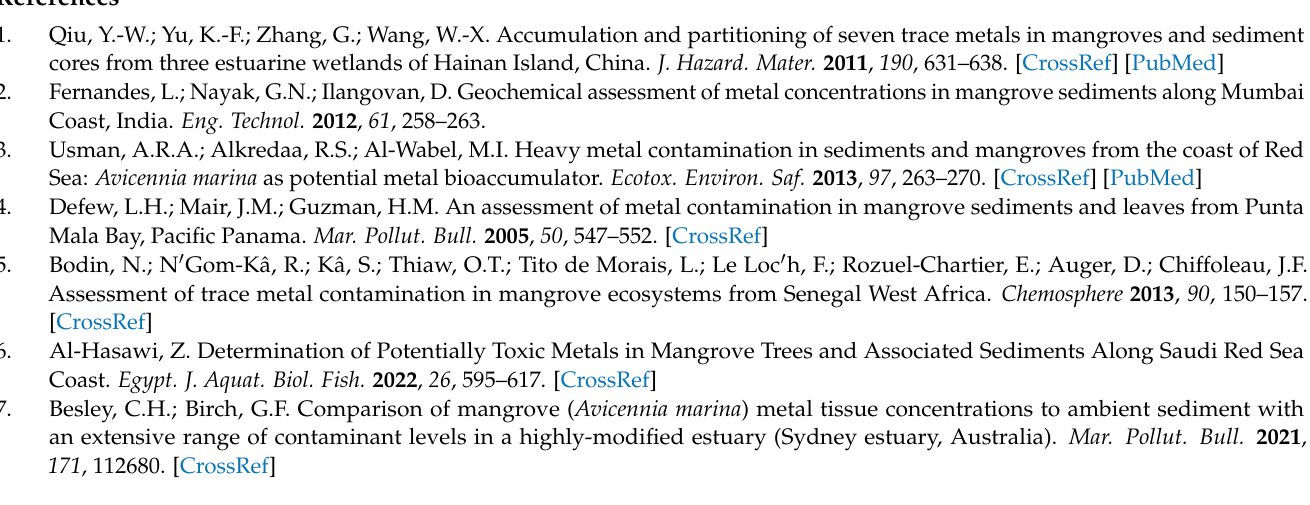
study; Table S2: Heavy metals analysis recovery percentages of the certified reference materials (CRM); Table S3: Mean concentrations (mg/kg dry weight) of Zn in the leaf parts (lamina (L); midrib plus petiole (MP)) of Rhizophora apiculata and their habitat geochemical fraction sediments, with their bioconcentration factor (BCF) values in the mangrove of Sepang Besar River (1–4), and Lukut River (4–9) from the present study; Table S4: Comparisons of concentrations (mg/kg dry weight) of Zn, Cu, Fe, Ni and Pb between surface sediments from this study with those cited from sediment quality guidelines, and reference values; Table S5: Mean concentrations (mg/kg dry weight) of Fe in the leaf parts (lamina (L); midrib plus petiole (MP)) of Rhizophora apiculata and their habitat geochemical fraction sediments, with their bioconcentration factor (BCF) values in the mangrove of Sepang Besar River (1–4), and Lukut River (5–9) from the present study; Table S6: Mean concentrations (mg/kg dry weight) of Pb in the leaf parts (lamina (L); midrib plus petiole (MP)) of Rhizophora apiculata and their habitat geochemical fraction sediments, with their bioconcentration factor (BCF) values in the mangrove of Sepang Besar River (1–4), and Lukut River (5–9) from the present study; Table S7: Mean concentrations (mg/kg dry weight) of Cu in the leaf parts (lamina (L); midrib plus petiole (MP)) of Rhizophora apiculata and their habitat geochemical fraction sediments, with their bioconcentration factor (BCF) values in the mangrove of Sepang Besar River (1–4), and Lukut River (5–9) from the present study; Table S8: Mean concentrations (mg/kg dry weight) of Ni in the leaf parts (lamina (L); midrib plus petiole (MP)) of Rhizophora apiculata and their habitat geochemical fraction sediments, with their bioconcentration factor (BCF) values in the mangrove of Sepang Besar River (1–4), and Lukut River (5–9) from the present study. References [57–59,61,62,74,76–81,85,105] are cited in the supplementary